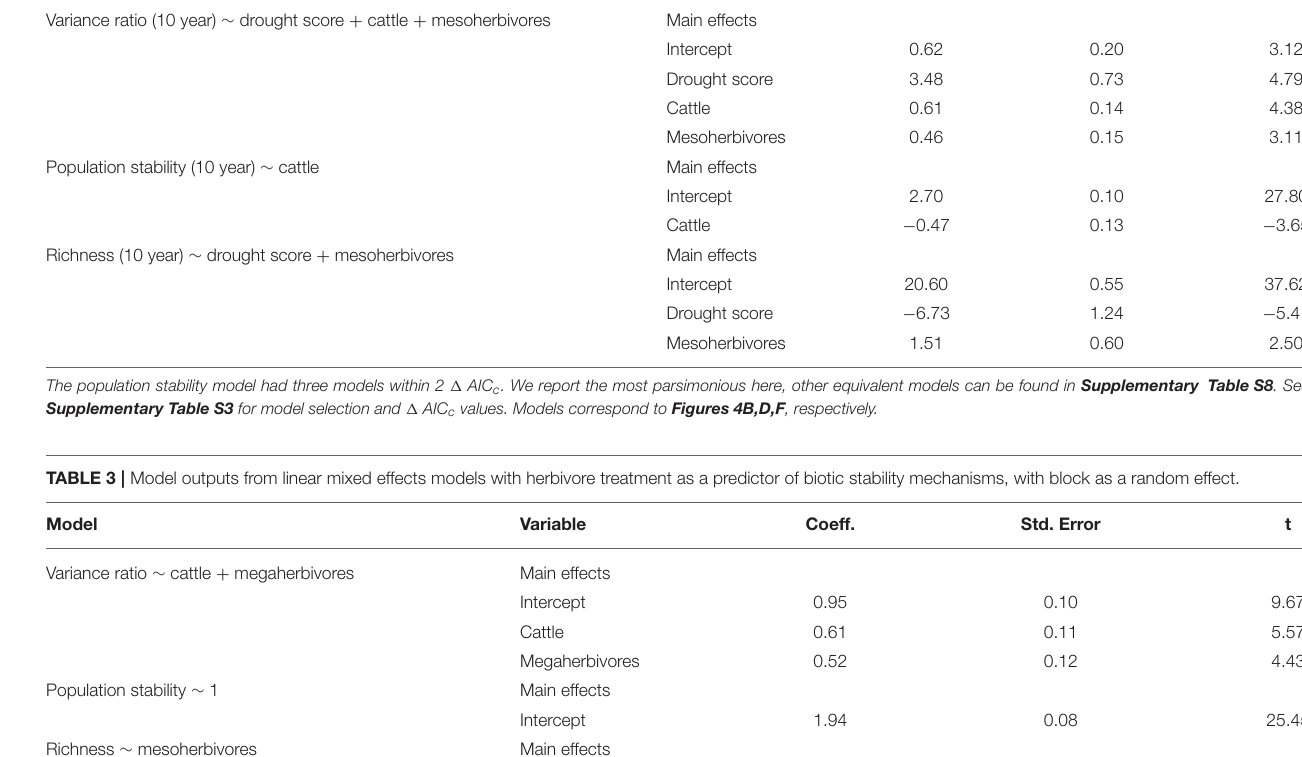
( Supplementary Figure S2 ). The relationship between drought and stability was negative across all three window sizes ( Supplementary Figure S8 ). The 15-year moving window had the weakest relationship likely because the window was large enough to average over trends ( Supplementary Figure S8C ). The total herbivore exclusion treatment was decoupled from this trend in the 5-year window analysis; at high drought score values it also had high stability ( Supplementary Figure S8A ), which may be due to one instance where it exhibited high resistance to drought ( Figure 2B − 2017). The relationship between synchrony (variance ratio) and the drought score were positive at all timescales, although the slope flattened slightly as the timescale increased ( Supplementary Figures S9A–C